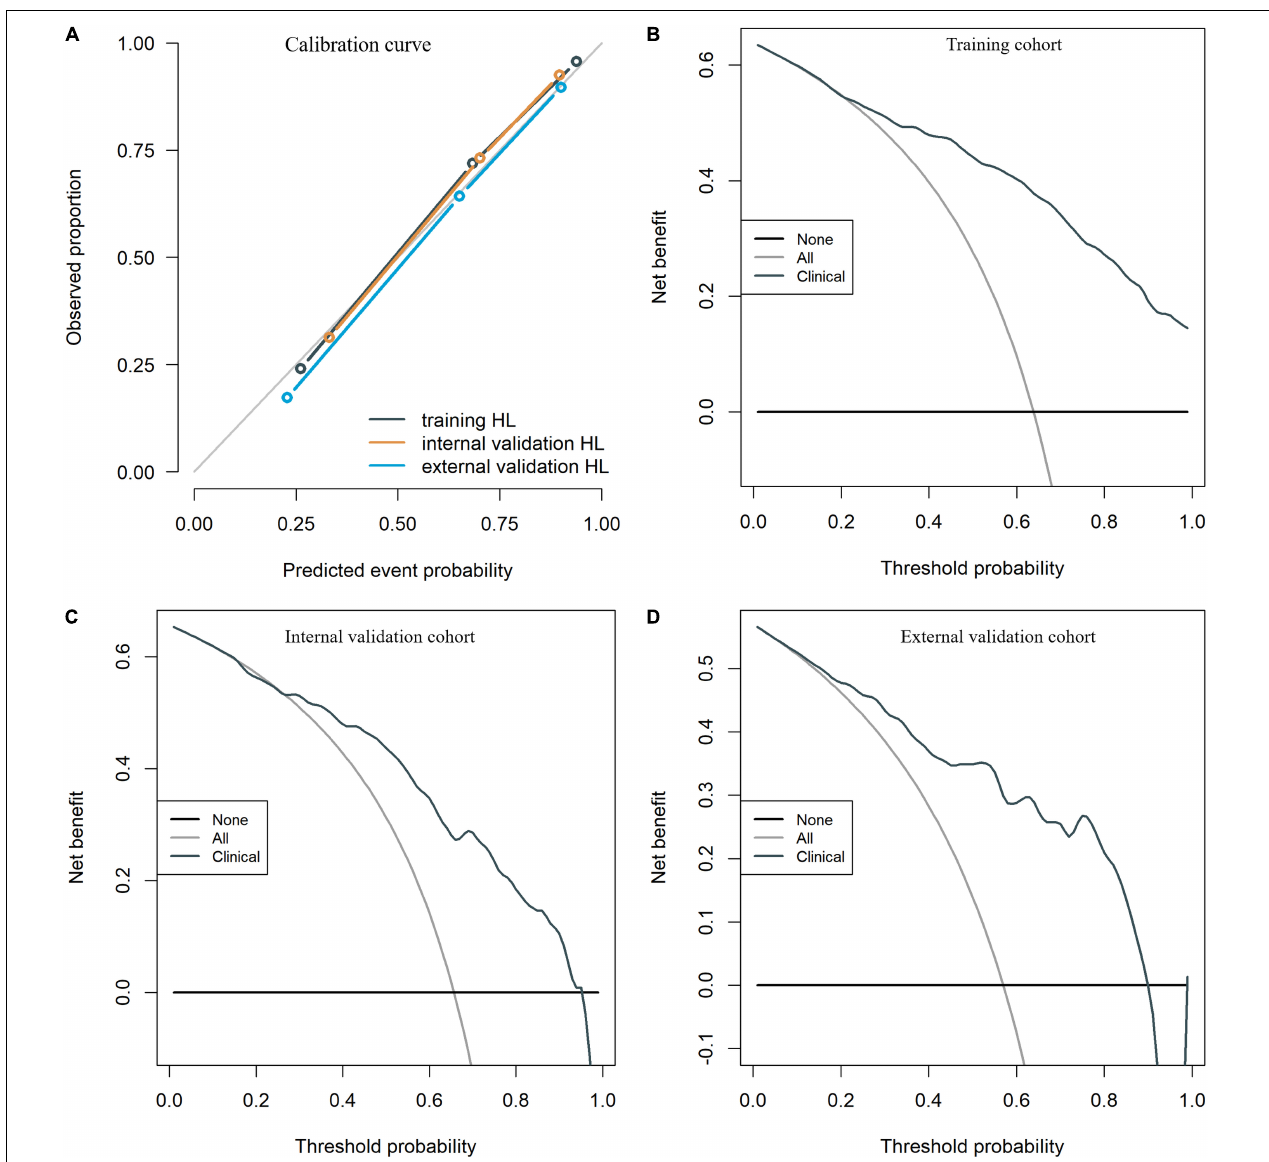
FIGURE 4 | The calibration curves for the clinical nomogram in the training and validation cohorts (A) . The decision curve for the clinical nomogram in the training (B) and validation cohorts (C,D)